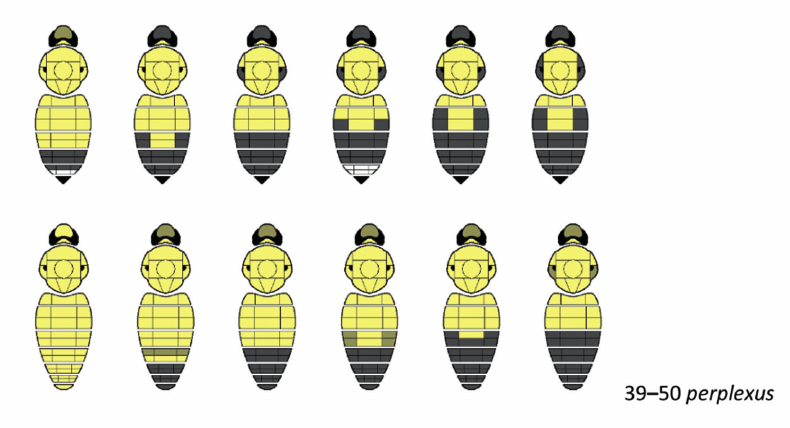
Figs 39–50. Simplified diagrams for the colour patterns of the hair on the dorsum for ♀♀ (above) and ♂♂ (below) of Bombus perplexus Cresson, 1863. The dorsum is divided into regions, each of wshich shows only the predominant or most apparent colour for that region using a simplified colour palette (precise shades vary), with olive indicating a mixture of black and yellow hair, and grey indicating a mixture of black and white